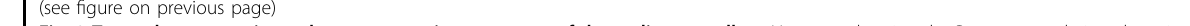
Fig. 3 Tumor heterogeneity and gene expression programs of the malignant cells. a Heatmap showing the Pearson correlation clustering of identi fi ed intra-tumor expression programs. b Heatmap showing the Pearson correlation clustering across gene signatures extracted from the PCA output. c Dot plots presenting the normalized expression levels of corresponding markers of each gene expression program of the malignant cells in the STRT dataset. d Scatterplot showing the developmental trajectory of malignant cell identi fi ed by different expression programs using monocle2. e Boxplot showing the signaling entropy rate of cells with identi fi ed gene expression programs. f Heatmap showing diverse expression patterns of the malignant cells from different expression programs along the pseudotime trajectory. g Scatterplot exhibiting the negative correlation of metabolism- and EMT-related malignant cells. h Scatterplot exhibiting the expression levels of representative marker genes. i Scatterplot exhibiting the information of malignant cells from lymph nodes and primary tumor tissues embedded in the trajectory pathway. j Heatmap showing the on or off activities in the malignant cells of diverse expression programs. k Scatterplot showing the TF expression scores in the developmental